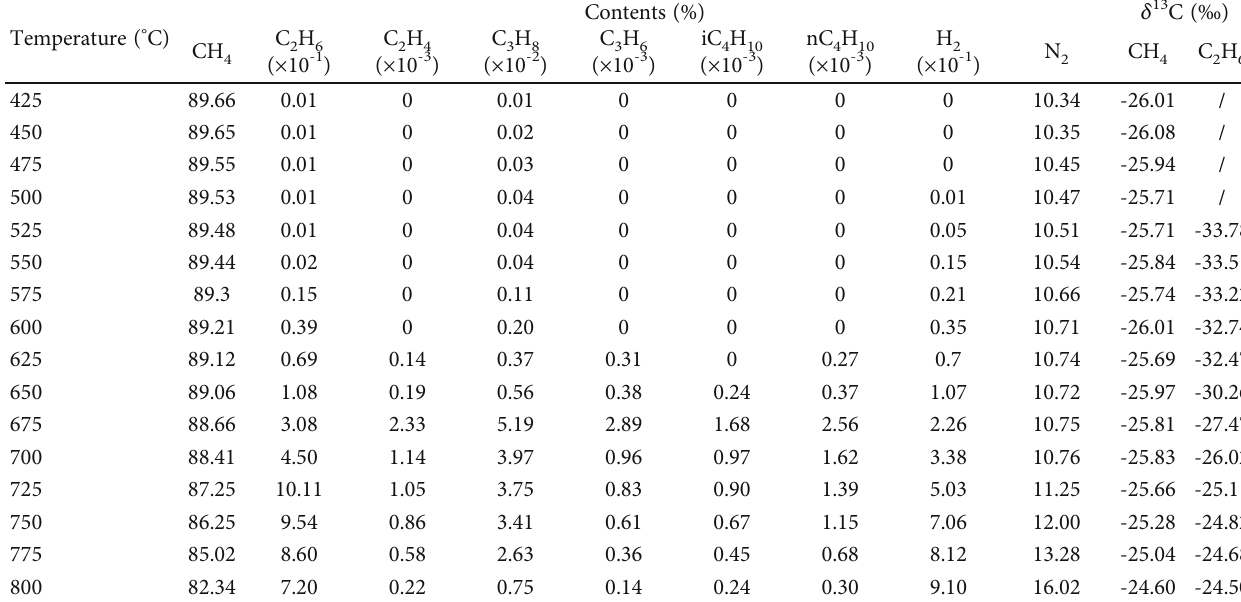
Figure 1: Comparison of carbon isotope peaks between reference and C Table 2: Components and carbon isotopes of gaseous products at di ff erent